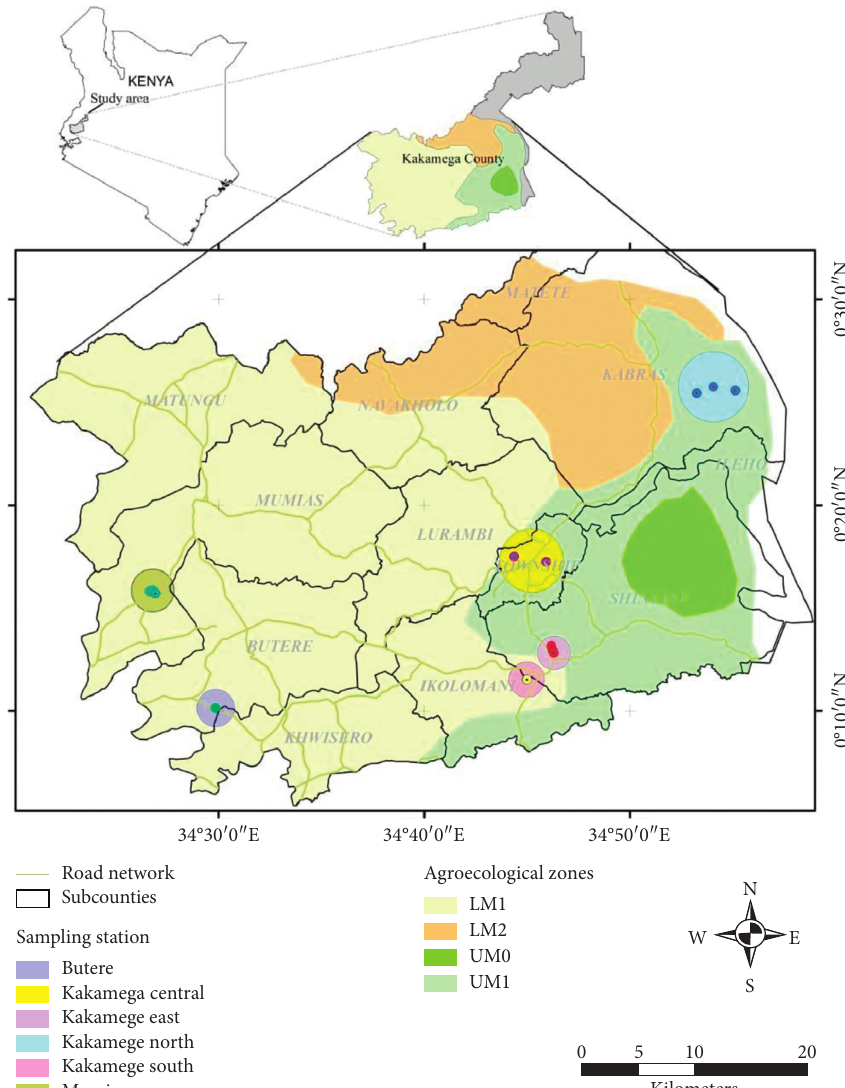
Figure 1: A map showing the study